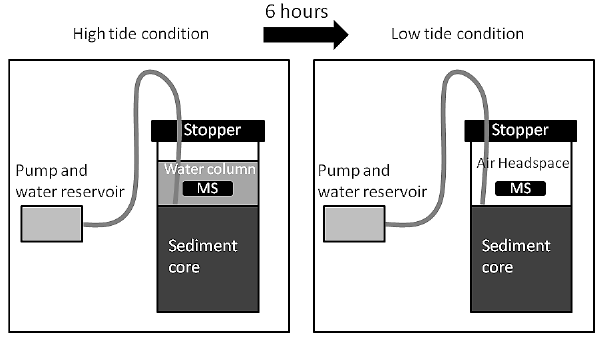
Fig. 1. Diagram of the experimental setup, showing the conditions of simulated tides. TA and DIC are sampled from the water col- umn during inundation (high tide) and CO 2 is sampled from the headspace during exposure (low tide). MS refers to a magnetic stir- rer